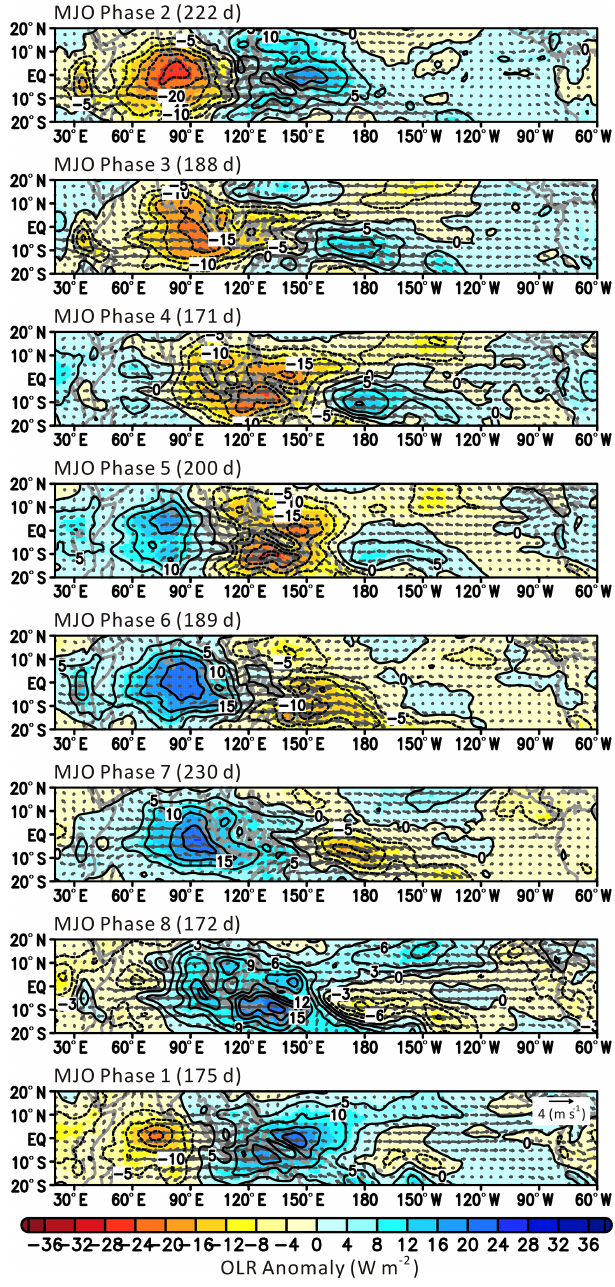
Figure 4. Composites of November to April 20–100d bandpass- filtered NOAA interpolated outgoing longwave radiation anomalies (color shades and contours, Wm − 2 ) and horizontal wind anomalies (vectors, ms − 1 ) at 850hPa from ERA-Interim, as a function of the eight phases of the MJO (Wheeler and Hendon 2004). The number of days for composites is indicated at the top of each panel. Years of analysis are from 1997 to